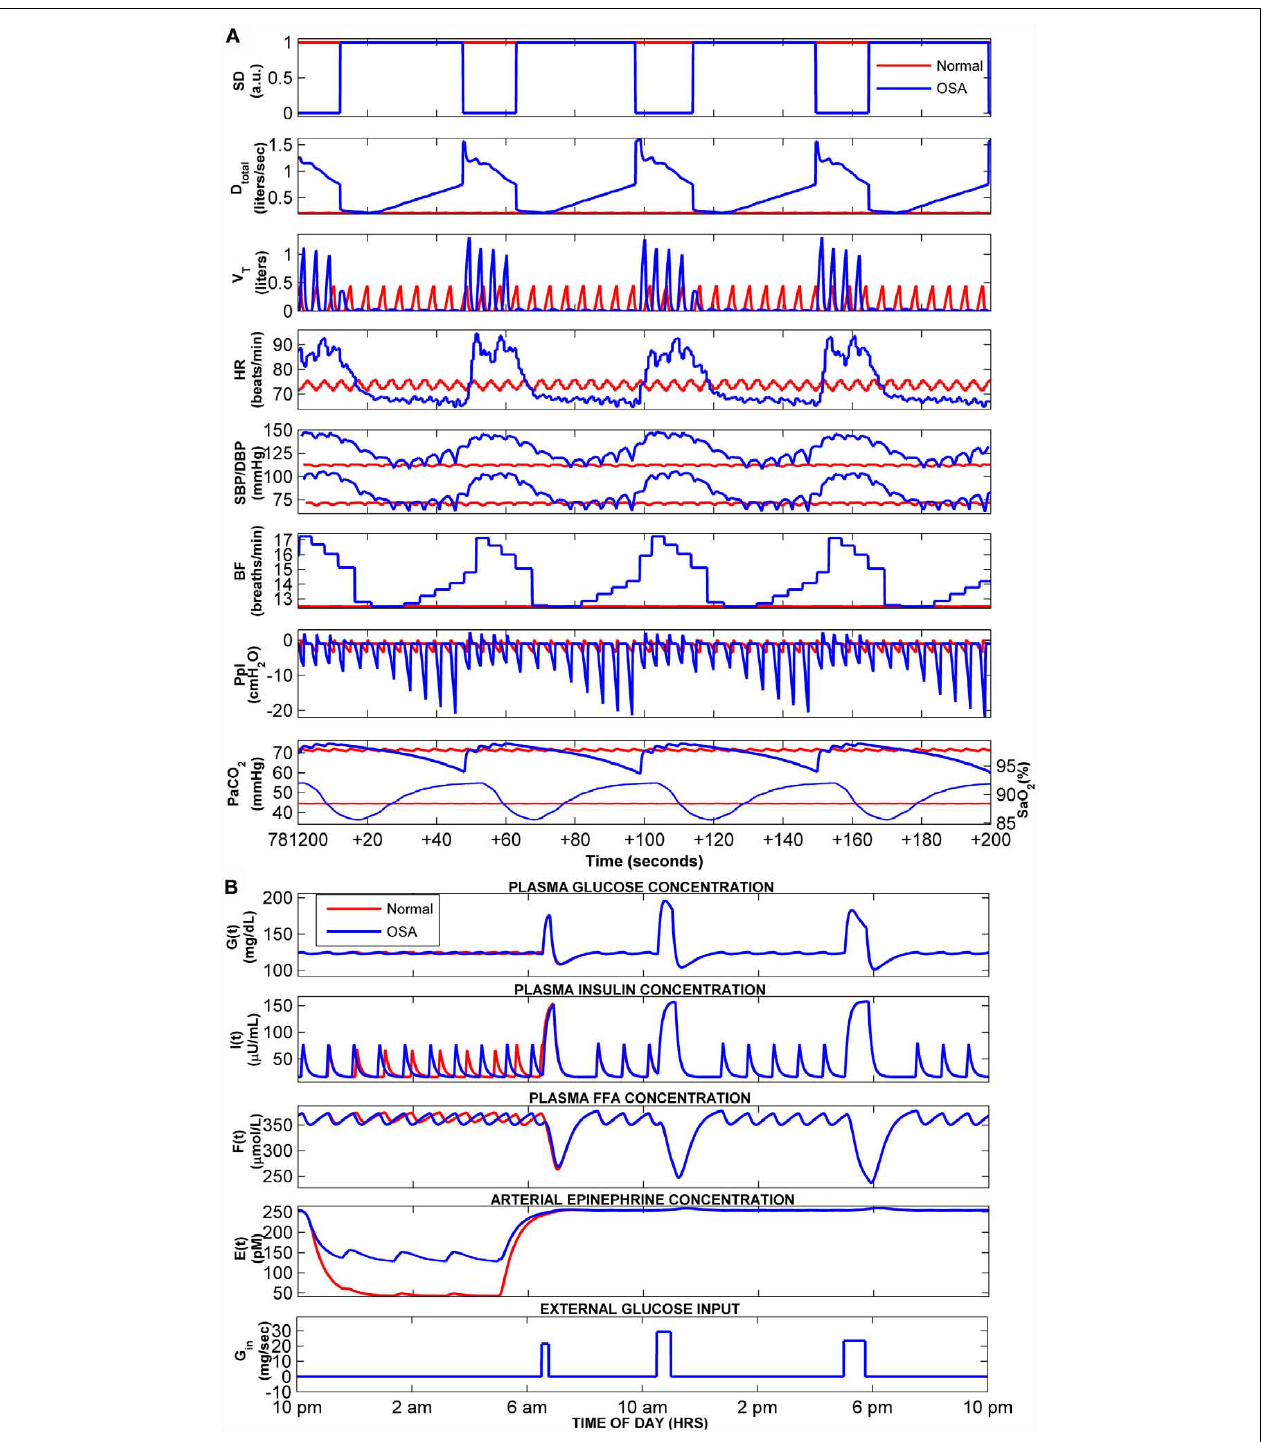
FIGURE 5 | Comparison of cardiorespiratory and metabolic responses in normal breathing (red) vs. OSA (blue). Results displayed are from Day 10 of the total simulation duration. Sleep starts at 10 pm and ends at 5 am each day. (A) Time-courses of the key cardiorespiratory variables – a segment of only 200s duration, starting at 11 pm of Day 10, is displayed for clarity. SD, sleep state index (wake/sleep = 0/1); D total , total ventilator drive (L/s); V T , tidal